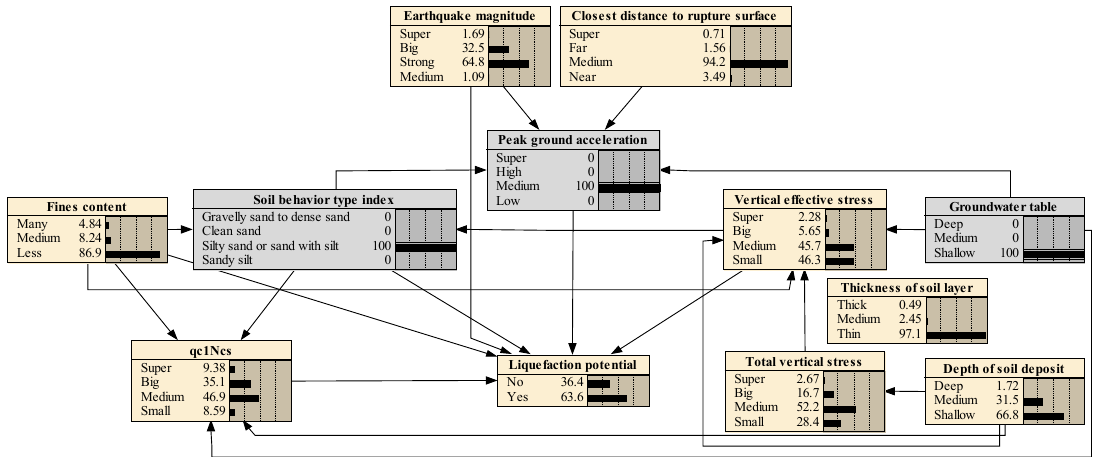
Figure 5. Liquefaction potential prediction when the states of evidence variables are: “ PGA = medium,” “ D w = shallow,” and “ I c = silty sand or sand with silt.”